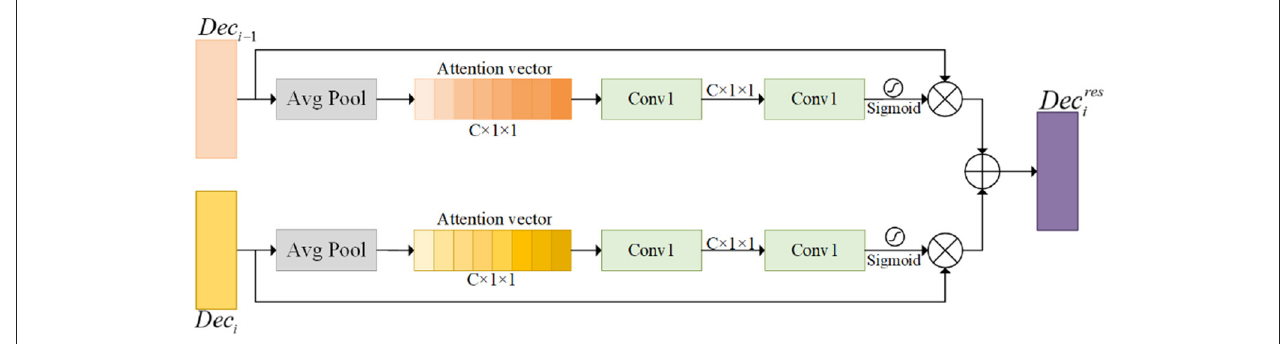
FIGURE 4 | This module is the Attention Fusion Module (AFM). The ⊗ represents element-wise multiplication, and the ⊕ represents element-wise sum.